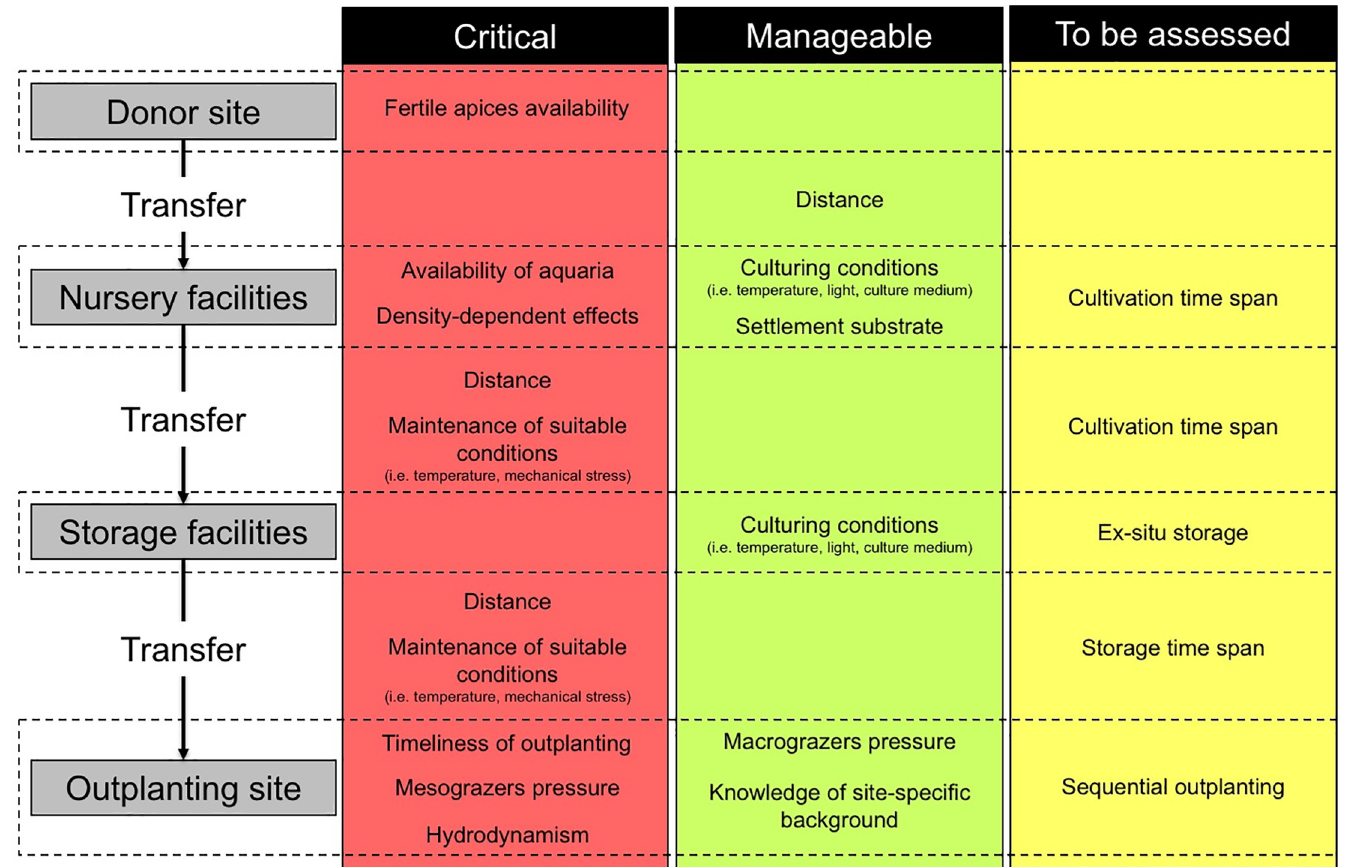
Fig 4. Schematic representation of C . amentacea ex-situ cultivation and outplanting. For each step of the restoration intervention, the red box synthetizes issues limiting its feasibility or representing sources of mortality for C . amentacea germlings, according to the present study. The green box presents manageable issues, according to the strategies adopted in the present study and described in the literature. In the yellow box, issues that still require to be addressed are introduced, as promising strategies to overcome criticalities.